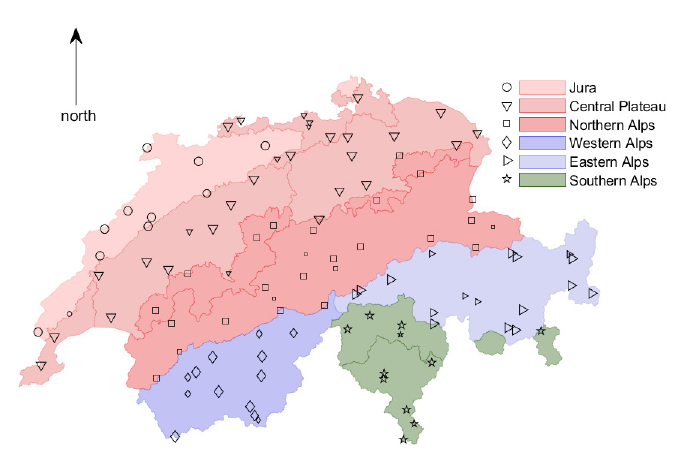
Figure 2. The six main biogeographical regions (11 subregions) [15] and the meteorological stations (marker size indicates amount of data available to reference for 30 years). The theoretical equilibrium MC has been calculated for 262 locations in the USA and 122 locations across the globe [23]. In Central Europe, autumn is generally the humid pe- riod and spring is the driest. The calculated monthly averages for MC from this study for Geneva, Bern, and Zurich, along with four other cities north and south of the Alps, are listed in Table 1. The MC averages are valid for softwood and based on the Simpson equa- tions (Section 2.6). There was little difference between the cities located in Switzerland, all of which are located in the Central Plateau region (Figures 1 and 2). It can be observed that the two cities south of the Alps experienced less variation in the predicted MC over the year than the two cities north of the Alps. Table 1. Predicted equilibrium moisture content (M%) in outdoor sheltered structures for four different months in a number of cities within, north of, and south of the Alps [23]. March